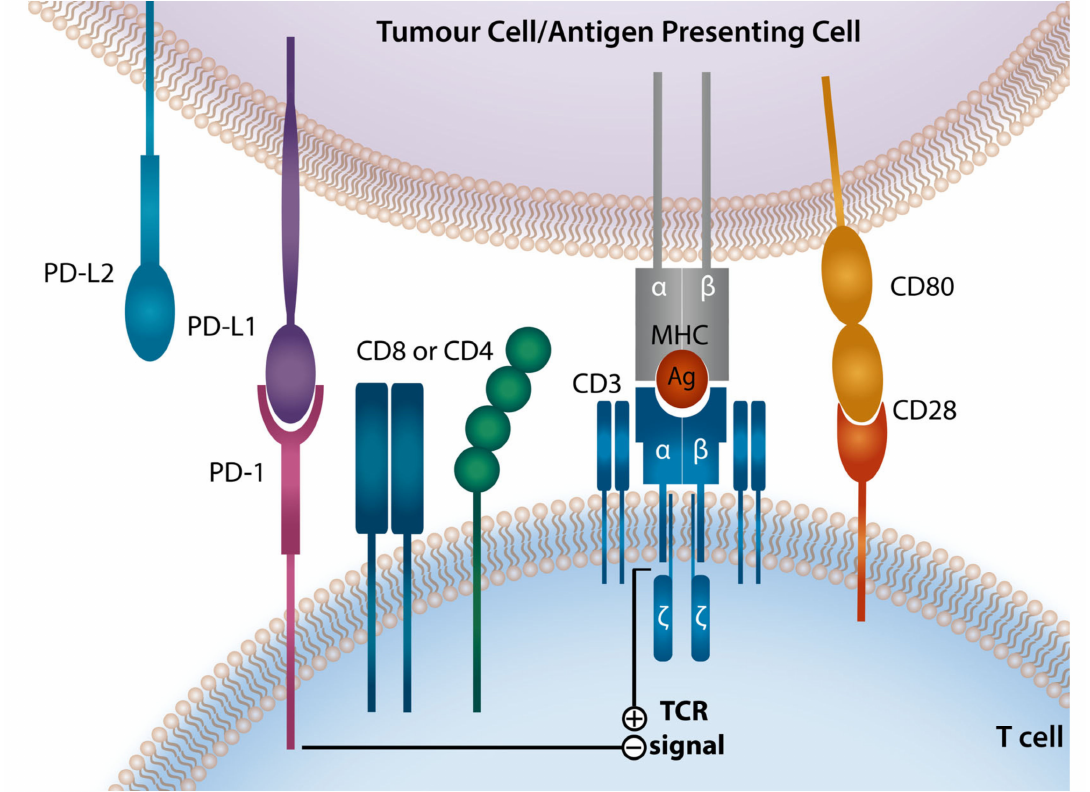
Figure 1. Programmed Death-1 Signaling Axis The PD-1/PD-L1/PD-L2 checkpoint pathway renders tumor cells resistant to T-cell immune attack. Ligation of T-cell PD-1 by PD-L1 or PD-L2 which are present on tumor cells or antigen presenting cell. PD-1 ligation dephosphorylates multiple members of the TCR signaling pathway attenuating TCR and CD28 signaling and promoting T-cell anergy and functional exhaustion. PD-1, programmed death-1; PD-L1, PD ligand-1; PD-L2, PD ligand-2; MHC, major histocompatibility complex; TCR, T-cell